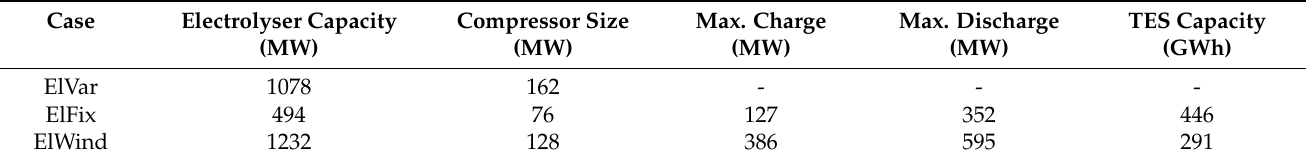
Table 3. Required capacities for producing district heat for